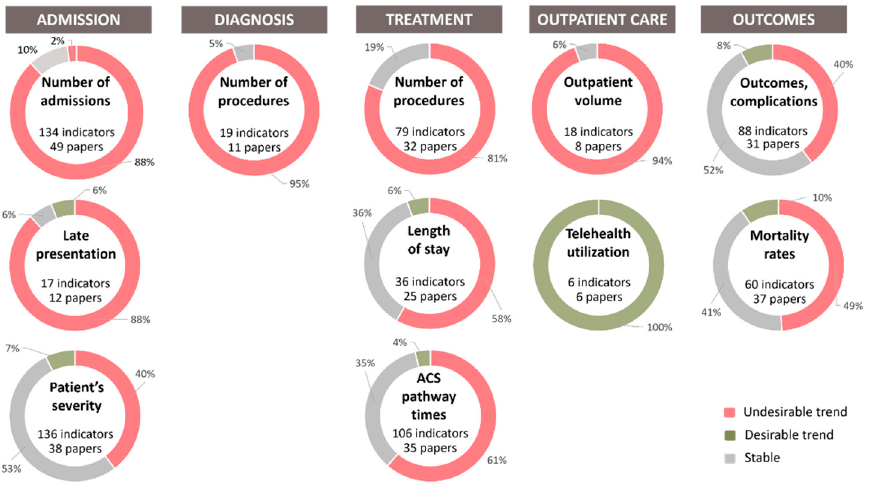
Figure 6. Hospital Cardiac Care Pathway Indicators’ Trends during the COVID-19 Pandemic’s early stages (January–June 2020). stages (January–June